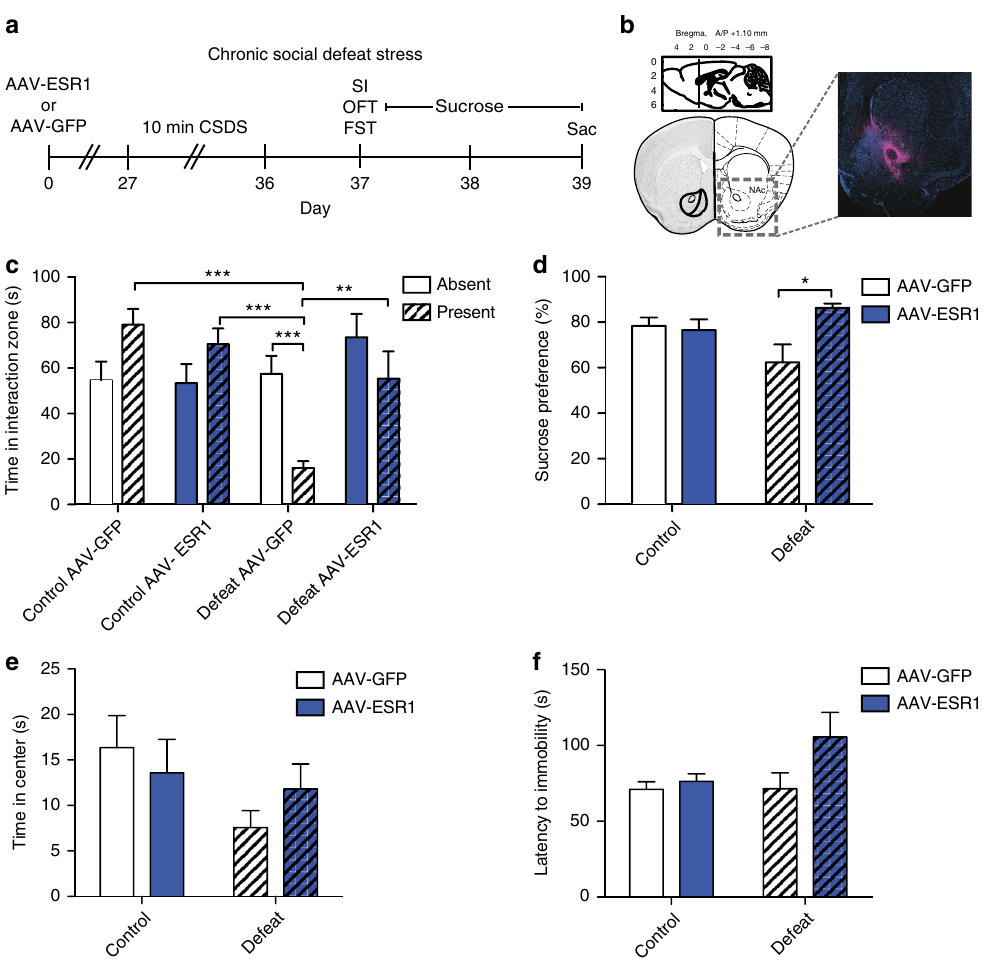
Fig. 3 ER α overexpression in NAc induces antidepressant-like effects in CSDS in male mice. a Timeline for CSDS experiment. b Location of targeted site within the NAc for viral-mediated gene transfer and IHC validation of viral expression (magenta) against DAPI background (blue). c Male mice show signi fi cant ( χ 2 (7) = 23.67, P < 0.001, n = 10,8,8,9) group differences in time spent in the interaction zone in the social interaction test. Defeated AAV-GFP mice, but not any other group, spend less time in the interaction zone when the CD1 aggressor is present than when the CD1 aggressor is absent ( P < 0.001). Additionally defeated AAV-GFP mice spend less time in the interaction zone when the CD1 aggressor is present than control AAV-GFP mice ( P < 0.001), control AAV-ESR1 mice ( P < 0.001), and defeated AAV-ESR1 mice ( P < 0.01). d There is a non-signi fi cant trend ( χ 2 (3) = 7.72, P < 0.052, n = 9,8,8,8) towards altered sucrose preference in the sucrose preference test with defeated AAV-ESR1 mice consuming signi fi cantly ( P < 0.05) more sucrose than defeated AAV-GFP mice. e , f CSDS ( F (1,32) = 2.96, P < 0.095; n = 10,8,9,9) and ER α overexpression ( F (1,32) = 0.05, P < 0.822) do not have an effect on time spent in the center in the open fi eld test or latency to immobility ( χ 2 (3) = 5.76, P < 0.124, n = 9,8,7,9) in the forced swim test. Data are represented as mean ± SEM. c , d , f Kruskal – Wallis test. e One-way ANOVA. * P < 0.05, ** P < 0.01, *** P < 0.001 post hoc independent-samples Mann –